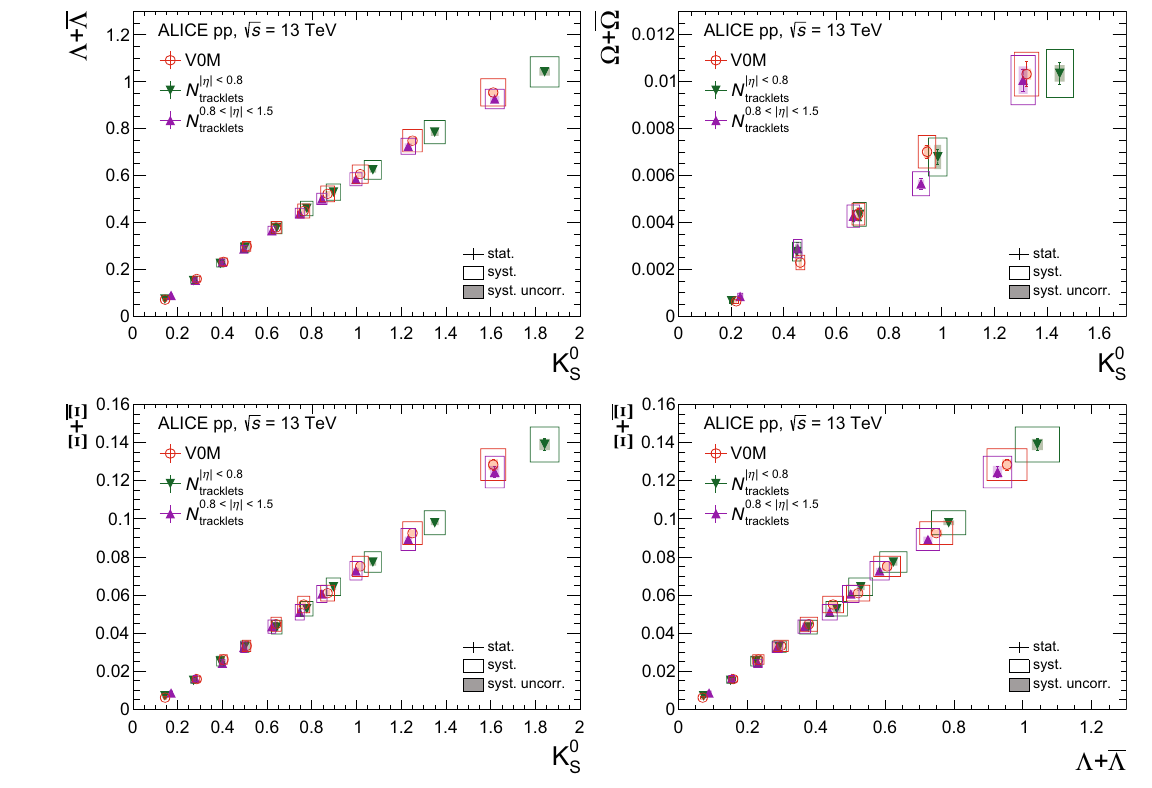
Fig. 10 Correlations between integrated yield of different strange hadrons in multiplicity classes selected according to different estima- tors (see text for details). Statistical and systematic uncertainties are